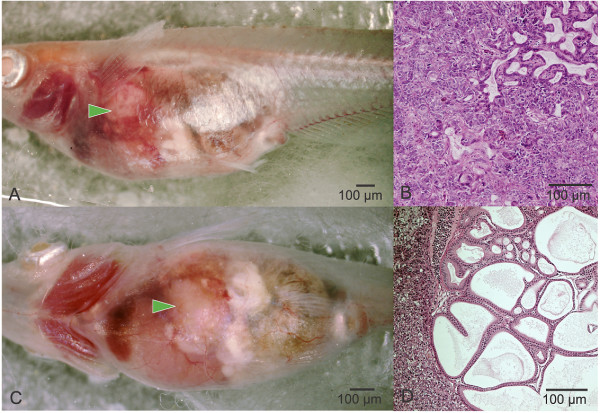
In vivo imaging of tumor formation in STII medaka: brightfield microscopy. Neoplastic response following early life stage exposure of STII medaka to the reference hepatocarcinogen diethylnitrosamine (DEN). Medaka acutely exposed at early life stages to DEN were followed serially, and at 10 months hepatic tumors were imaged through the abdominal wall. (A and C) In vivo imaging (brightfield) of hepatic tumor formation (green arrowheads) in DEN exposed medaka, showing enlargement of total liver mass and altered vasculature. Histopathological assessment of the tumor showed mixed hepatocellular (B) and cholangiocellular carcinomas (D). Biliary hyperplasia (D) was characterized by a single layer of biliary epithelium lining large cystic spaces in the liver. Opaque white tissue in brightfield images (A&C) is ovary, whereas the gut occupies caudal most region of the abdominal cavity.